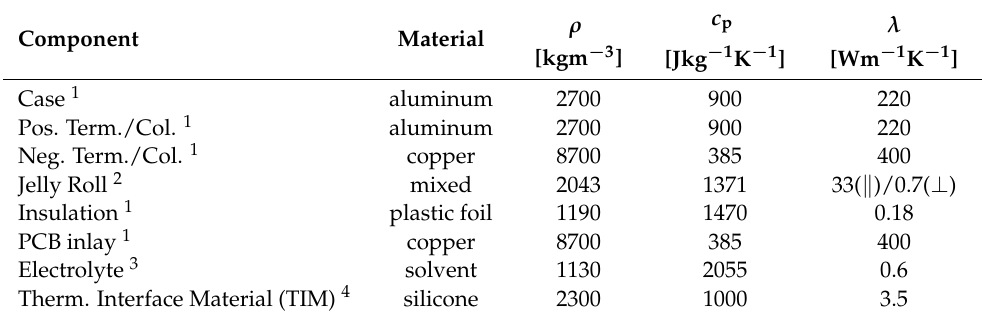
Table 1. General physical and thermal parameters of the used components for the TECM model.